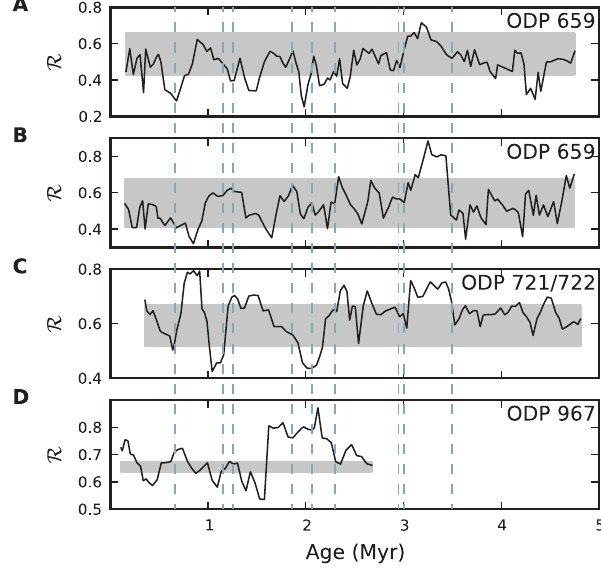
Fig. 11. Evolution of RN assortativity R for (A) the δ 18 O record from ODP site 659, and the dust flux records from ODP sites (B) 659, (C) 721, and (D) 967 during the Plio-Pleistocene. Parameters, significance test, and vertical lines are the same as in Fig. 9.